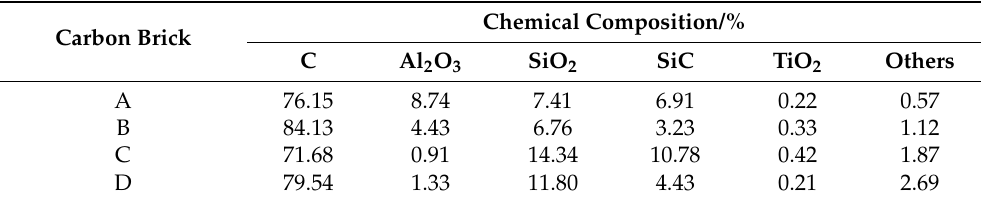
Table 1. Chemical composition of the four types of carbon bricks.